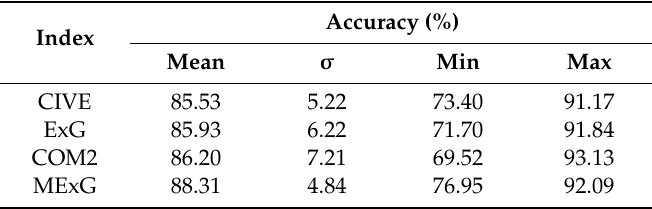
Table 5. Performance evaluation on our data set.